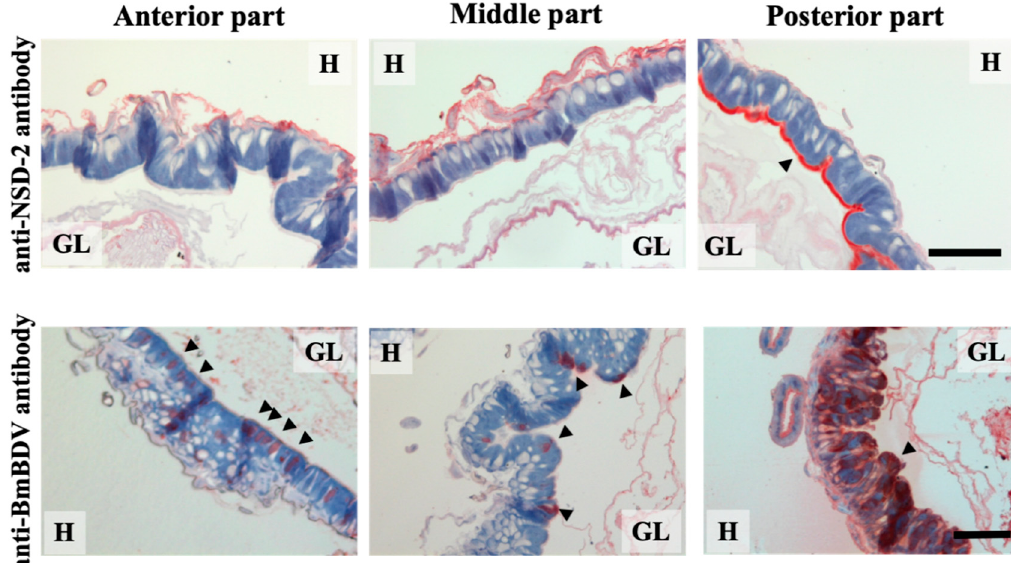
Figure 3. The NSD-2 and the BmBDV protein’s location in the different parts of the midgut. The upper and lower panels show the immunofluorescence analysis using an anti-NDS-2 antibody and anti-BmBDV antibody, respectively. Paraffin section prepared from the midgut of larvae from the fifth instar day three or four were developed with the ABC Kit and 3-Amino-9-ethylcarbazole solution, and the nuclei were counterstained with hematoxylin. Red-colored regions and arrowheads show the NSD-2 and BmBDV protein’s locations. GL, gut lumen; H, hemolymph. Scale bar, 100 µ m. This figure is a partial modification of Ito et al. [17].